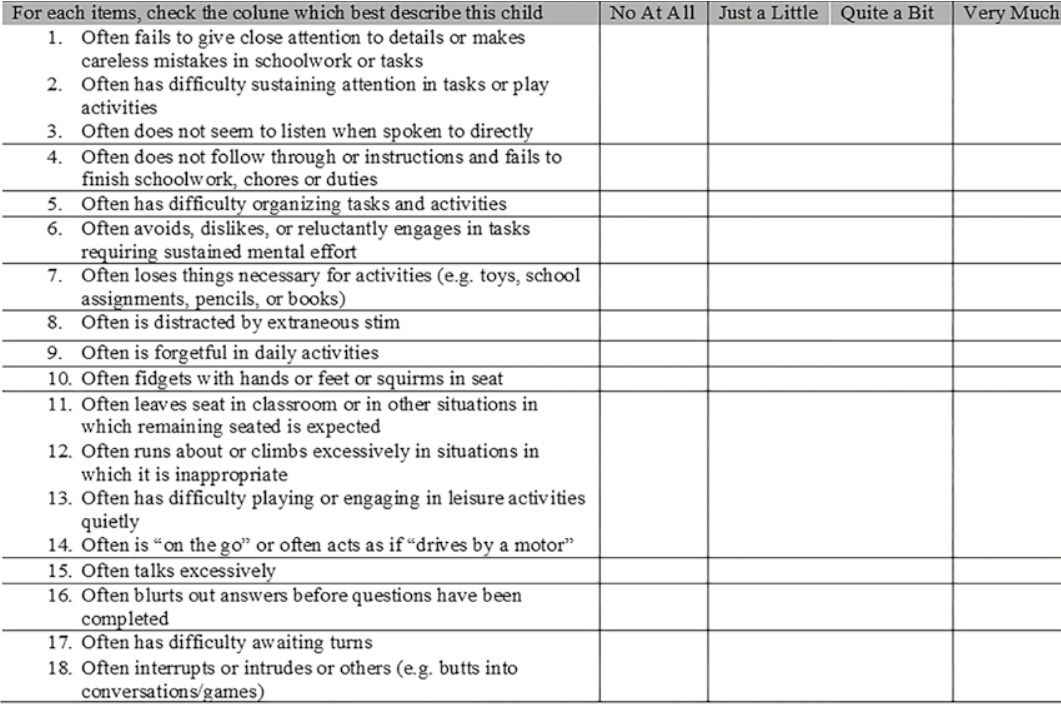
Figure 1 - Multimodal Treatment Study for ADHD of the Swanson, Nolan, and Pelham version IV (MTA-SNAP-IV) adapted from Mattos et al.